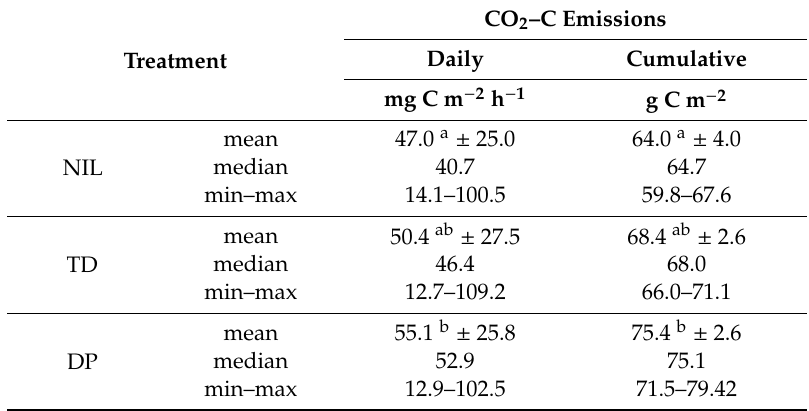
Table 3. Daily CO 2 –C soil emissions and total cumulative CO 2 –C soil emissions from the soil treated with NH 4 NO 3 in the top dressing (TD) and deep placement (DP) fertilization